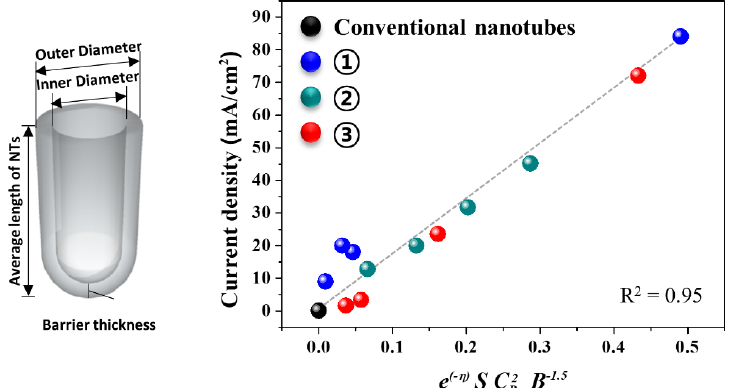
Figure 7. Linear relationship of the alkaline OER current density with the overpotential and the morphological parameters of doping concentration, surface area, and nanotube thickness for RuO 2 -doped TiO 2 nanotubes. ① , ② , and ③ correspond to RuO 2 doping via single-step anodization in organic solvent, single-step anodization in aqueous conditions, and potential shock in aqueous conditions. Reproduced with permission from reference [31]. Inha University (2018).